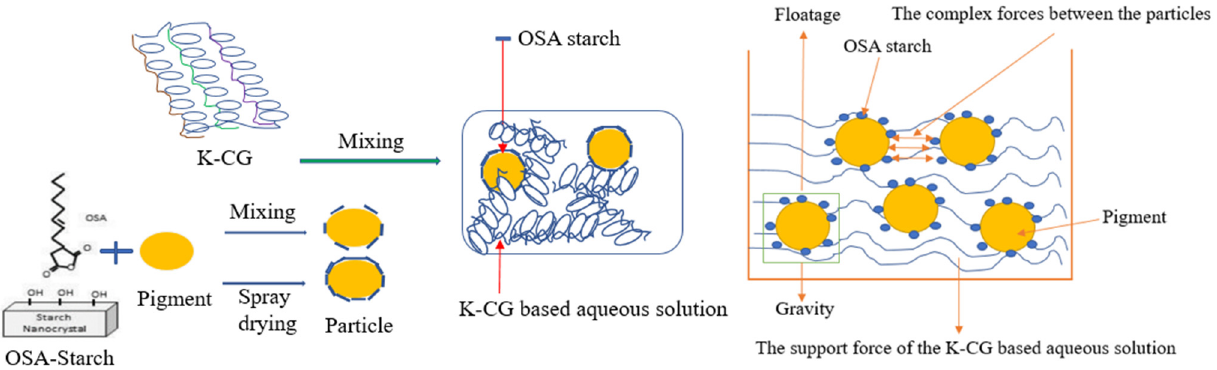
Figure 10. Schematic diagram of process flow and particle suspension mechanism.